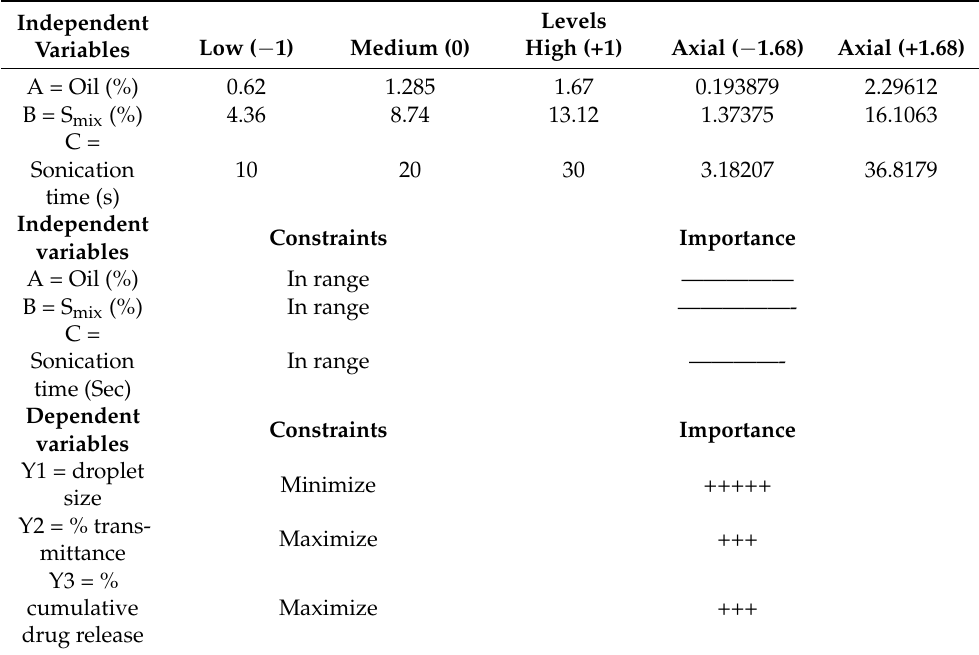
Table 6. Selected independent variables along with their levels and dependent